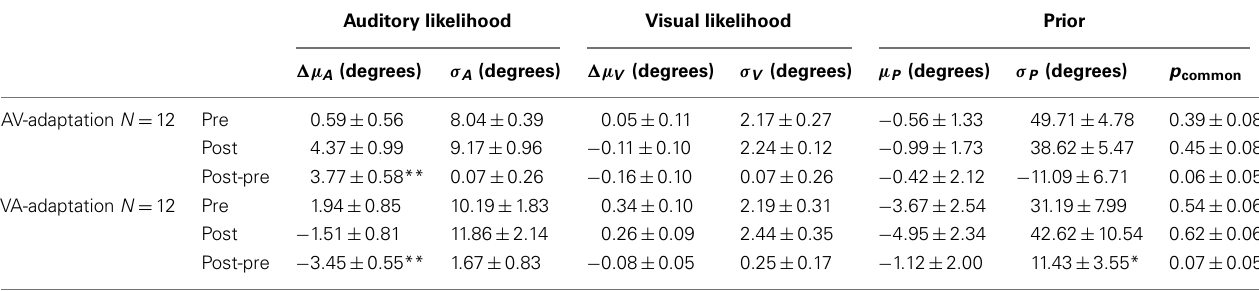
Table 1 | Sample mean ± SE parameter estimates for each adaptation group.